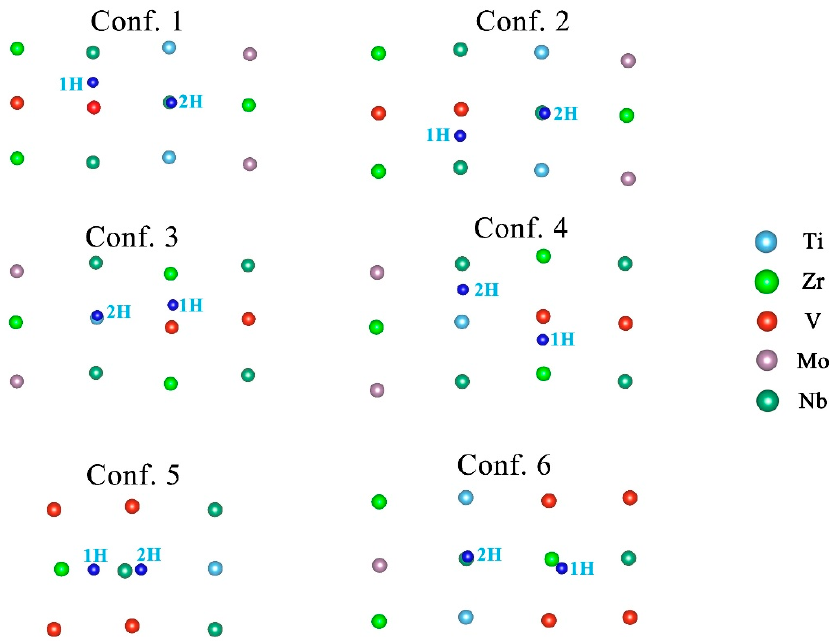
Figure 8. The local distribution of metal atoms around the desorbed hydrogen atoms in the six configurations for atomic hydrogen desorption on the HEA TiZrVMoNb hydride (110) surface. Markers 1H and 2H present each of the two hydrogen atoms.